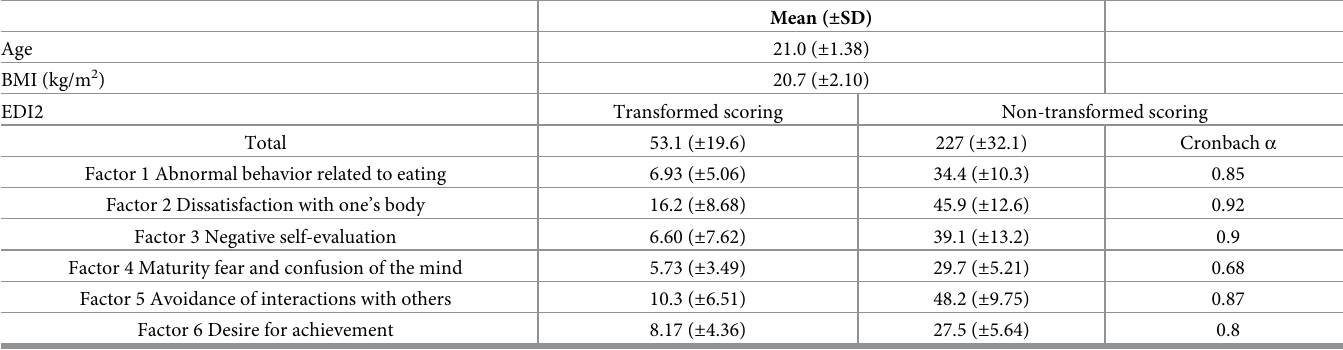
Table 1. Characteristics of the study